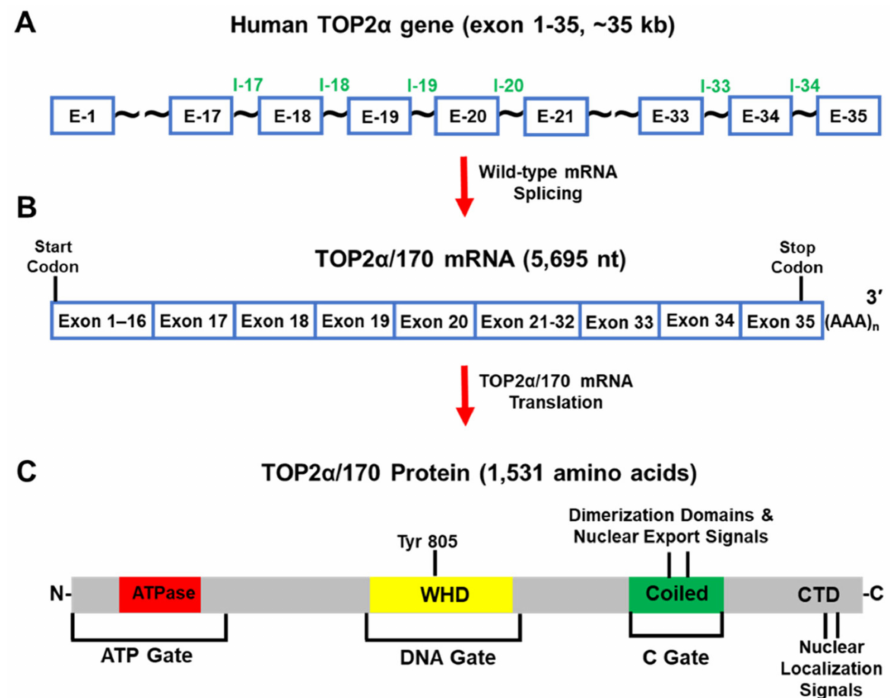
Figure 5. Schematic representation of the human TOP2 α gene, TOP2 α /170 mRNA, and TOP2 α /170 isoform. ( A ) The human TOP2 α gene comprises 35 exons and spans ~35 kb. ( B ) The well-characterized TOP2 α /170 mRNA transcript is 5695 nucleotides long. ( C ) This mRNA transcript encodes a TOP2 α isoform of 1531 aa, denoted TOP2 α /170. The TOP2 α /170 isoform harbors the ATP-gate/ATPase domain; the DNA-gate which includes the active site Tyr-805 and a winged-helix domain (WHD); the C-gate containing protomer dimerization sequences and nuclear export signals; the C-terminal domain (CTD) which contains the nuclear localization